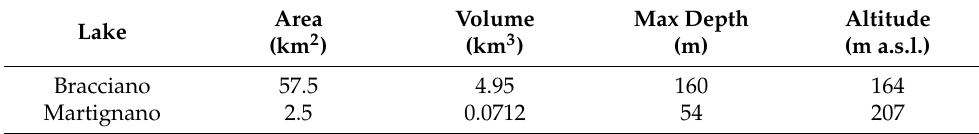
Table 1. Morphometric characteristics of the two volcanic lakes considered in this study